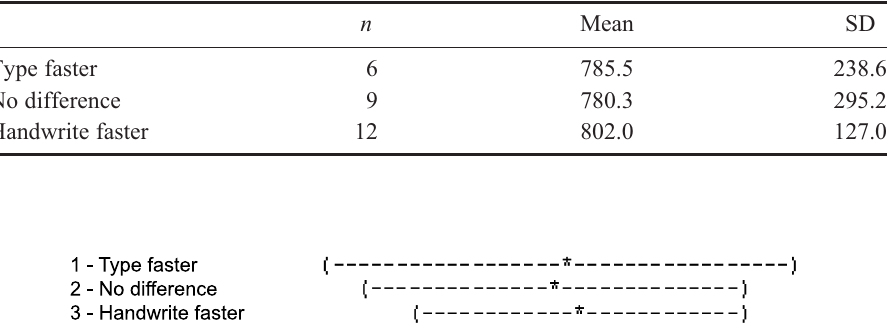
Table 1. Number of words written by students handwriting or typing.